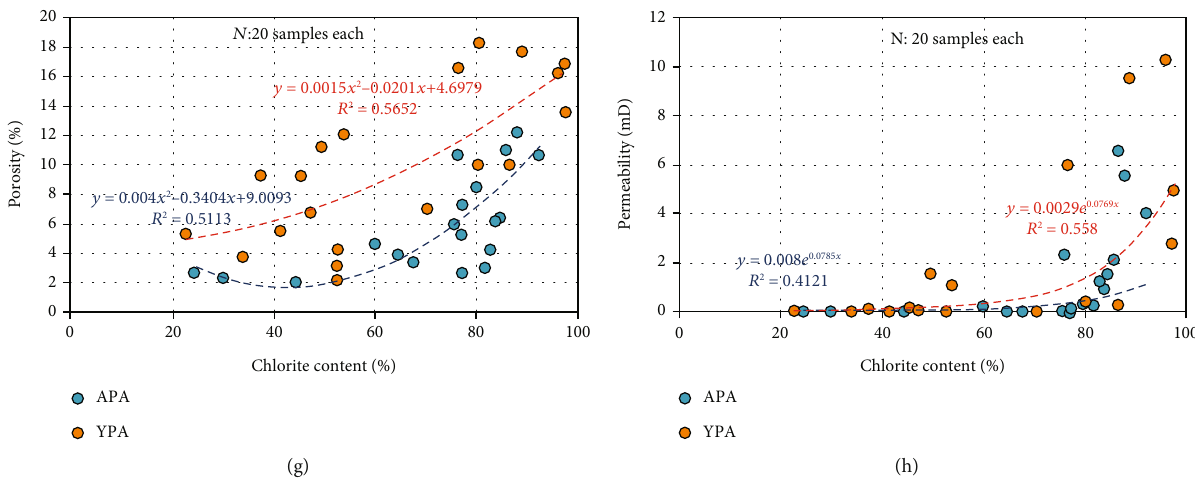
Figure 12: Relationship between di ff erent types of clay minerals and physical properties in the YPA and APA. (a) Di ff erence in the correlation between the illite content and porosity. (b) Di ff erence in the correlation between the illite content and permeability. (c) Di ff erence in the correlation between the illite/smectite mixed layer content and porosity. (d) Di ff erence in the correlation between the illite/smectite mixed layer content and permeability. (e) Di ff erence in the correlation between the kaolinite content and porosity. (f) Di ff erence in the correlation between the kaolinite content and permeability. (g) Di ff erence in the correlation between the chlorite content and porosity. (h) Di ff erence in the correlation between the chlorite content and